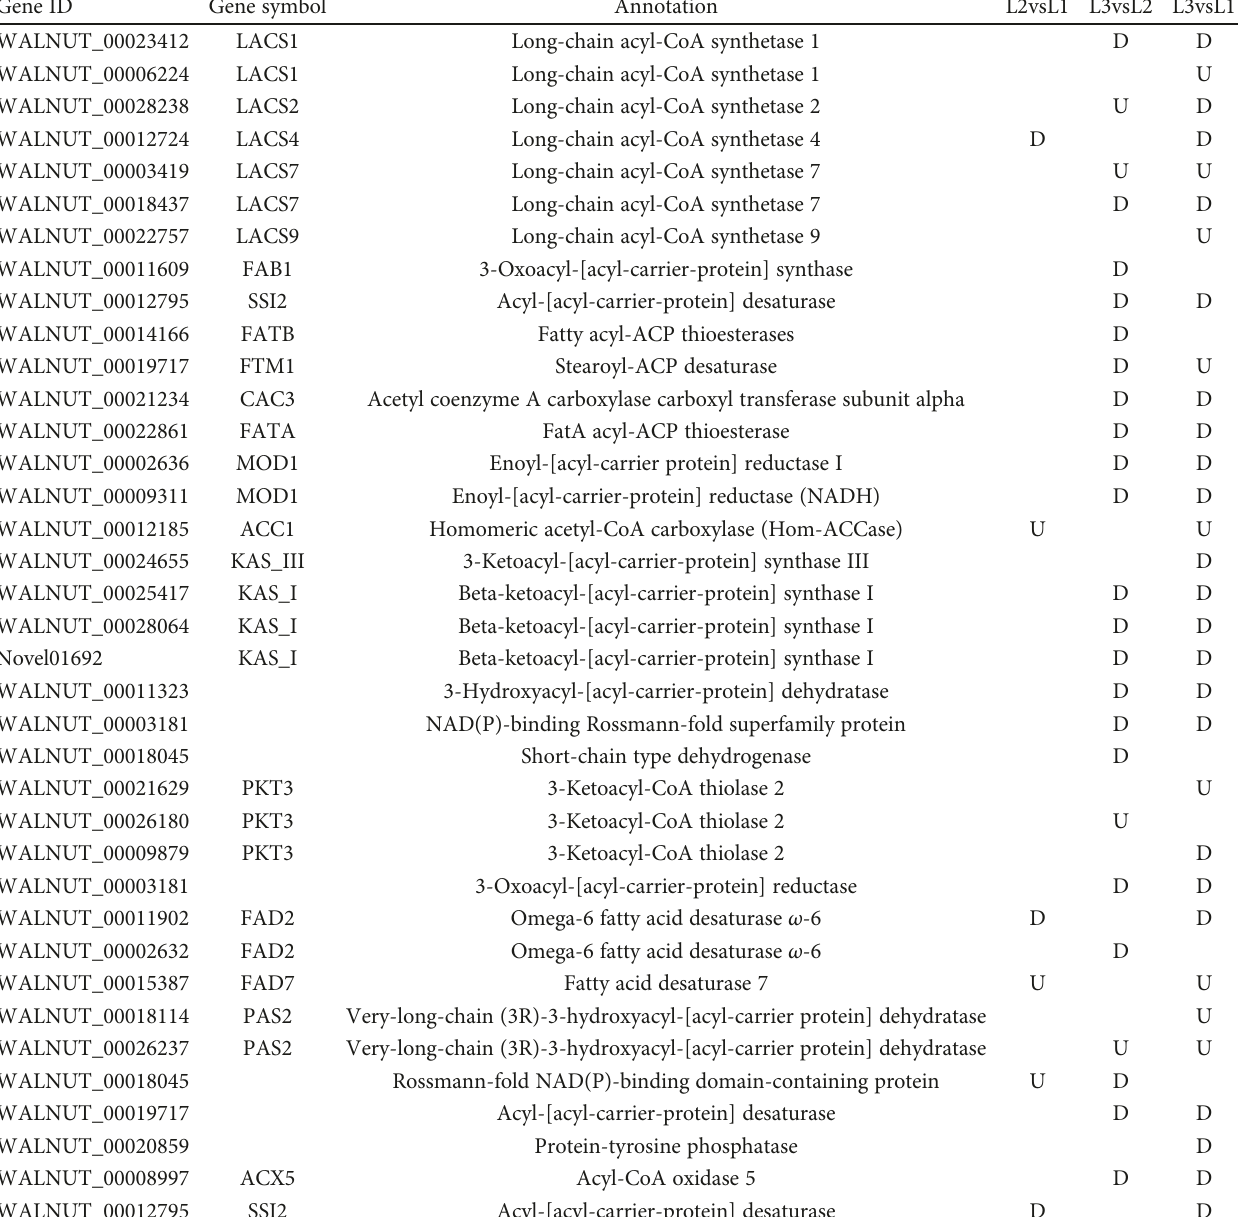
Table 6: Di ff erentially expressed genes in fatty acid